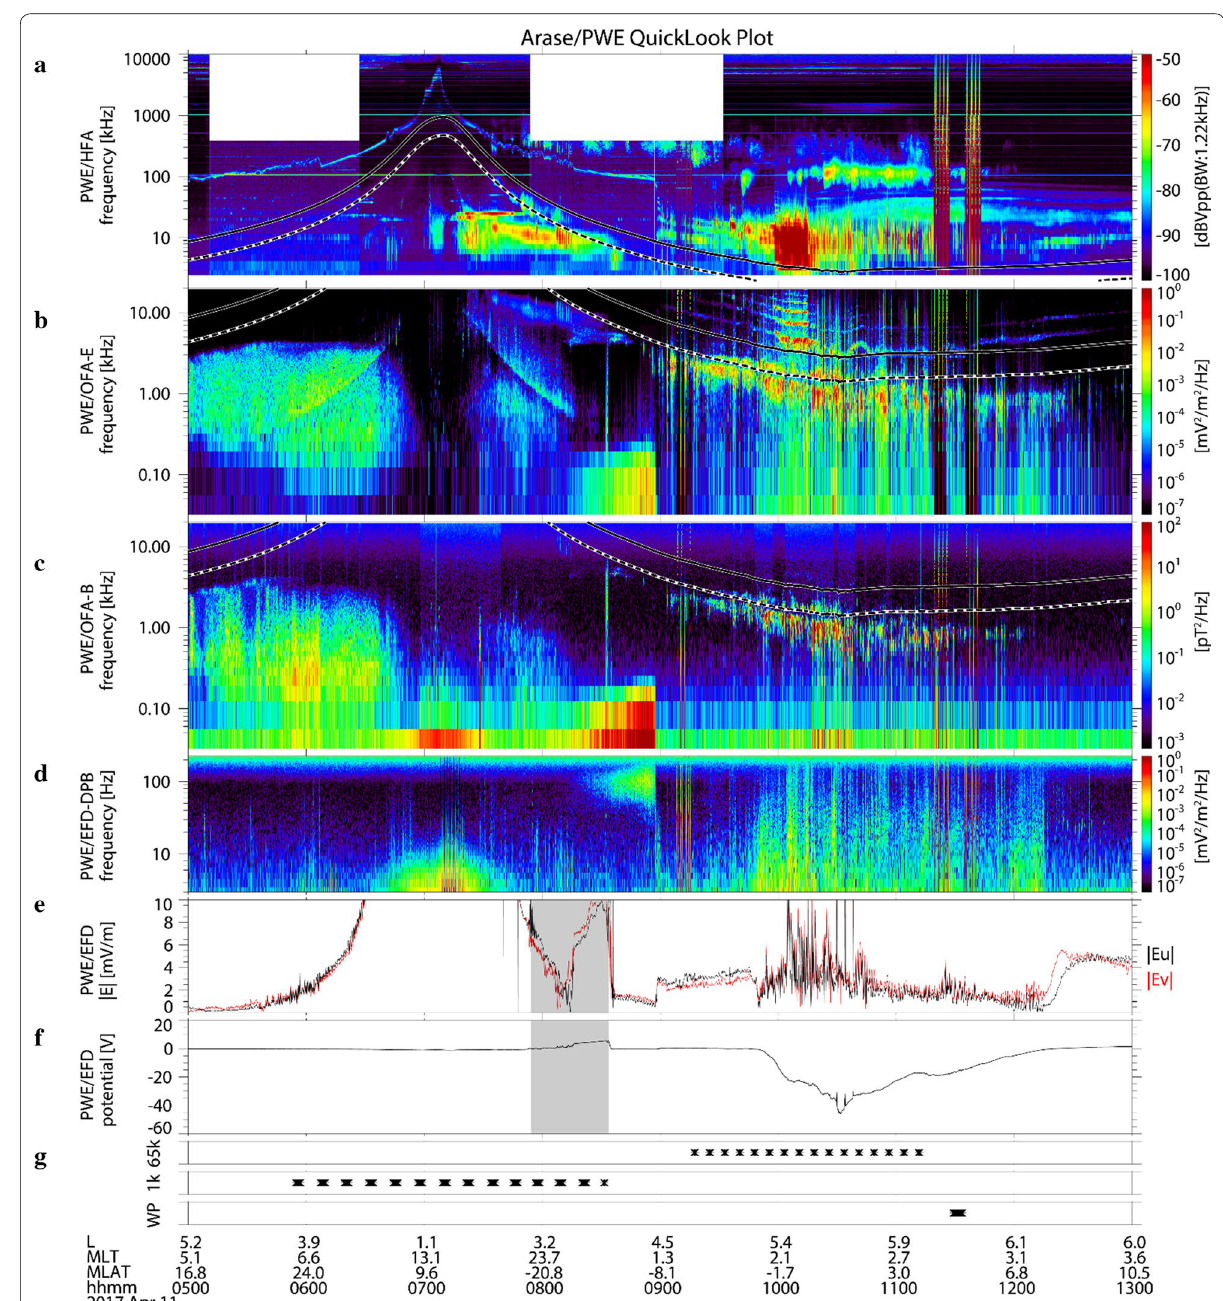
Fig. 19 Example stack plot of the HFA, OFA, and EFD observed on April 11, 2017. a electric wave spectrogram (HFA), b electric wave spectrogram (OFA-E), c magnetic wave spectrogram (OFA-B), d electric wave spectrogram (EFD), e DC electric field (EFD), f satellite potential (EFD), and g active periods of the PWE burst operation. The solid and dotted lines shown in panels a–c indicate the local electron cyclotron frequency ( f c ) and half of f c , respectively, derived from the DC magnetic field measured by the MGF. The shadows superposed on panels e and f represent the eclipse period that occurred from 07:53 to 08:34 UT along the trajectory of the Arase. “65 k”, “1 k”, and “WP” shown in panel g correspond to the time durations of “chorus burst”, “EMIC burst” and S-WPIA mode operations,